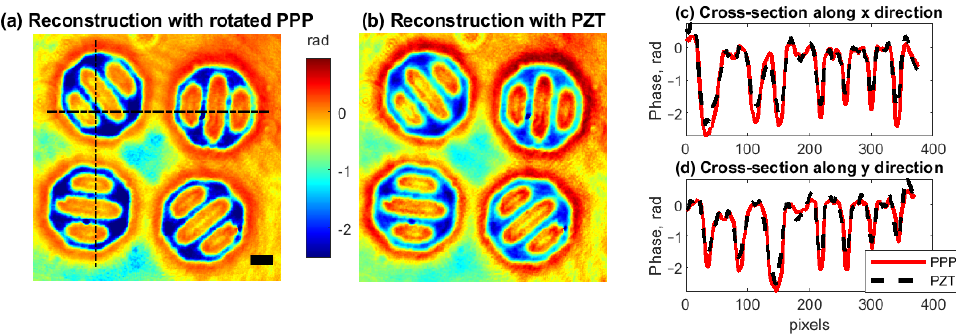
Figure 6. PSDH reconstructed phase with implementation by rotated PPP ( a ) and by PZT ( b ). Longitudinal cross-sections are in subplots ( c , d ) for x and y directions, correspondingly. Scale bar is 50 µ